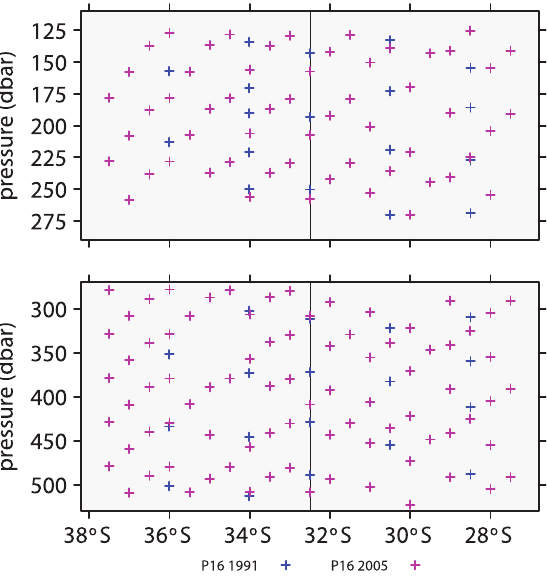
Figure 2. Locations of data from P06 surveys. The vertical lines indicates where P06 and P16 cross. Blue indicates data from 1992; magenta, 2003; green, 2009 and 2010.